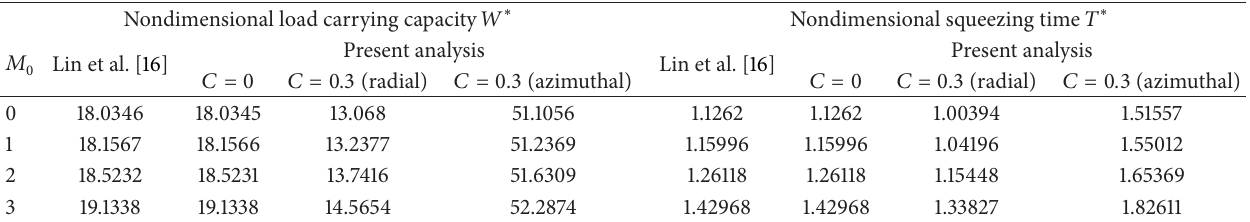
Table 1: Numerical comparison of load carrying capacity and the squeezing time between Lin et al., [16] and the present analysis with = 0.5 . 𝐻 ∗ = 0.4 , 𝑙 ∗ = 0.3 , and ℎ ∗ 1 Nondimensional load carrying capacity 𝑊